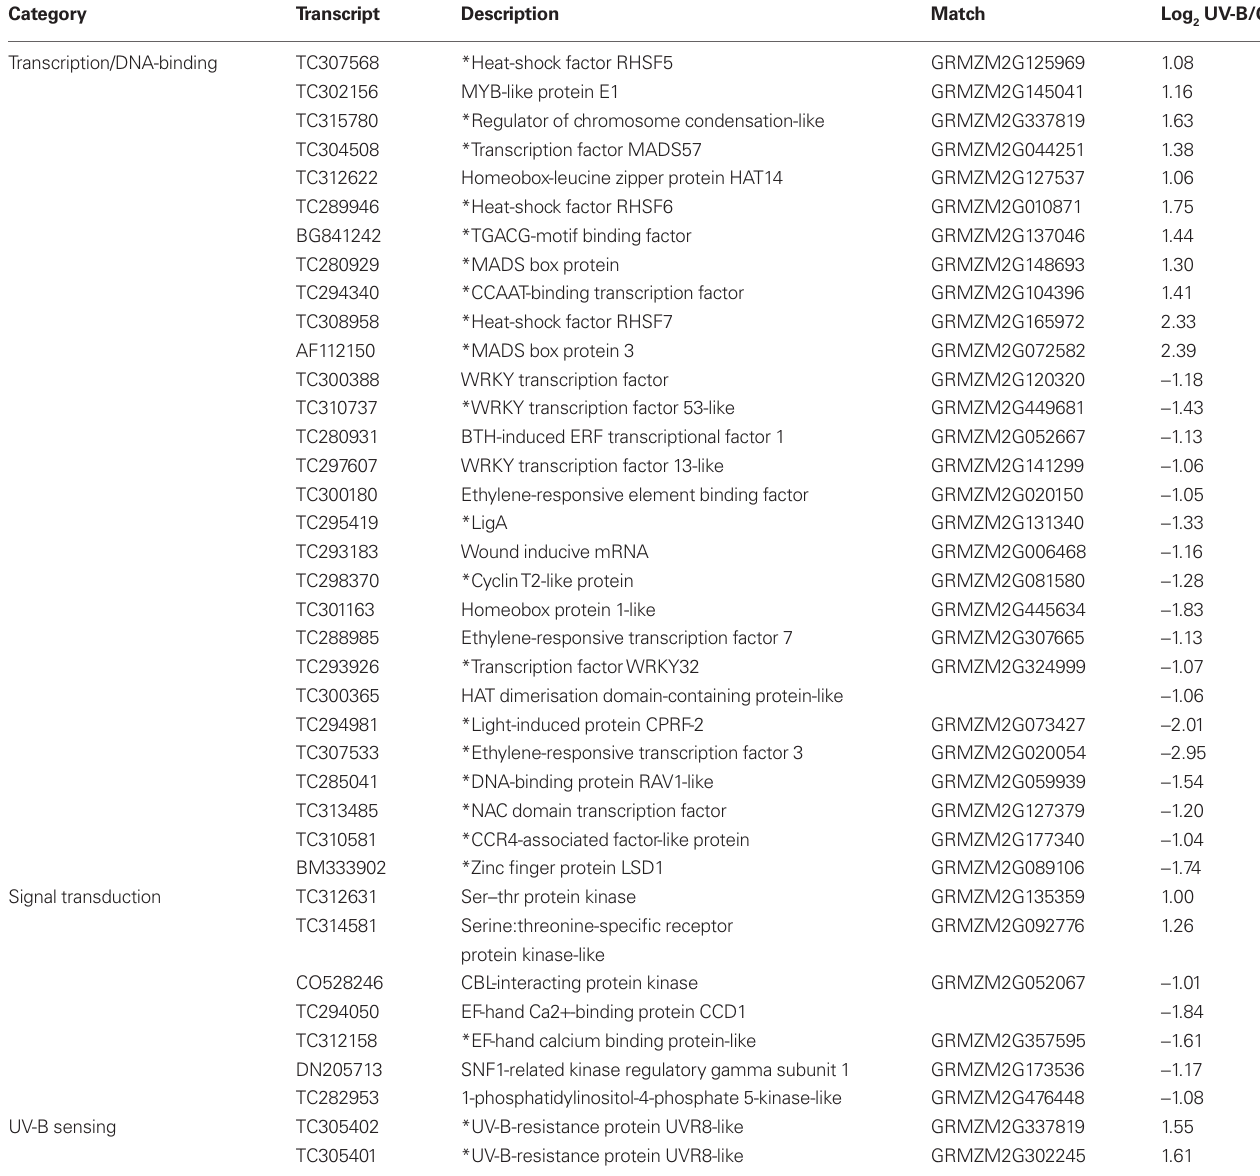
Table 2 | List of transcripts encoding transcription factors, sensing, and signal transduction proteins that are UV-B-regulated in iL after 10 min of